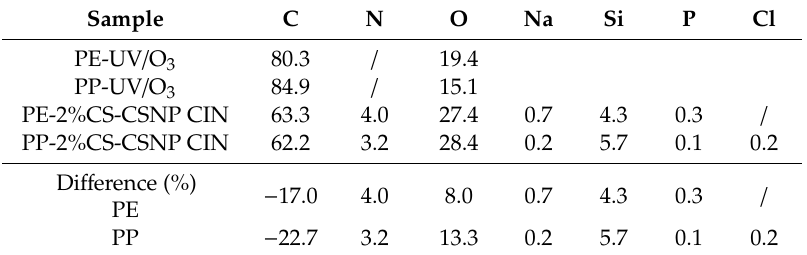
Table 9. Surface chemical composition of the reference foils and foils treated by the two-layer coating: PE-2%CS-CSNP CIN in at.